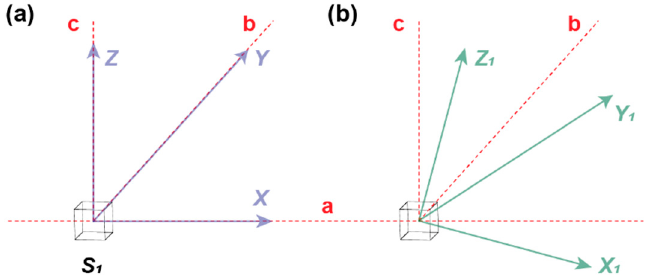
Figure 5. The difference between ideal coordinate ( a ) and real coordinate ( b ) about the orthogonal error. The a-b-c coordinate system is the reference coordinate. Under ideal condition, the output coordinate system coincides with the reference coordinate, as shown in Figure 4a. However, under real condition, there will be a deviation as shown in Figure 4b. For Equation (3), α x , β y and γ z are the angle between x and x 1 , y and y 1 , z and z 1 , respectively. Accordingly, α y , α z , β x , β z , γ x , and γ y are the angle between x and y 1 , x and z 1 , y and x 1 , y and z 1 , z and x 1 , z and y 1 , respectively.